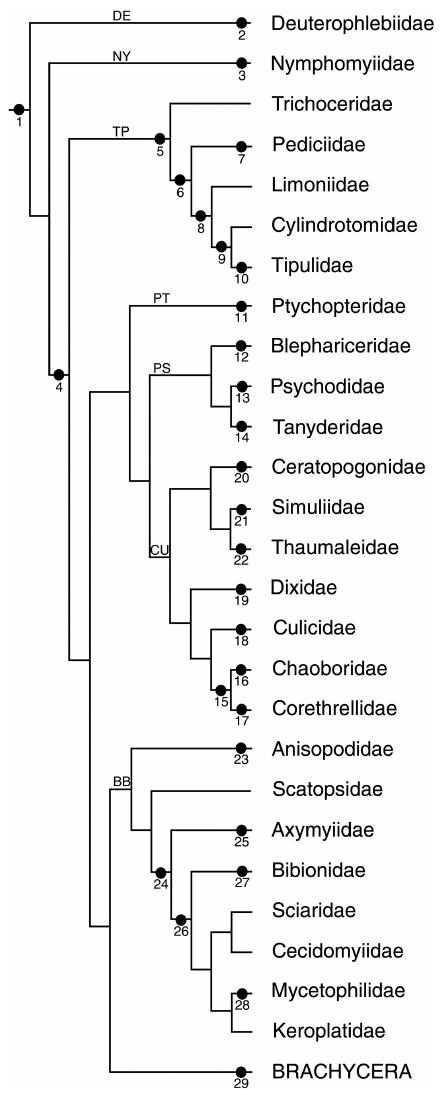
Figure 2 . Characters mapped on the cladogram of Wiegmann et al. [23, Figure 1]. potential apomorphies indicated by black points. 1, Diptera: Adult head: dense vestiture of microtrichia, presence of a clypeolabral muscle, reduction of the postmentum, transformation of the labial palps into labellae (equipped with simple furrows). Larval head: labrum equipped with a dense fi eld of hairs, presence of a hypostoma (hypostomal bridge) with triangular teeth. 2, Deuterophlebiidae: Adult head: antenna inserted laterally, widely separated, last antennal segment extremely elongated, labrum, maxilla, and labium reduced (inclusive associated muscles), reduction of M. tento- riobuccalis anterior and M. hypopharyngosalivarialis. Larval head: presence of externolateral plates with growth lines (homoplasious character), labral brush consists of macrosetae, reduction of M. labroepipharyngalis, bifurcate distal antennal segment, presence of apical multitoothed mandibular comb (homoplasious character), largely membranous cardo. 3, Nymphomyiidae: Adult head: completely sclerotized rostrum, club-shaped antenna with enlarged fi rst and elongated terminal segment, completely reduced tentorium, reduction of labrum, maxilla, and labium (inclusive associated muscles), loss of M. tentoriobuccalis (homoplasious character). Larval head: comple- tely reduced tentorium, labral brush consisting of macrosetae, reduction of M. labroepipharyngalis, bifurcate distal antennal segment, presence of an apical multitoothed mandibular comb. 4, Diptera, exclusive Deuterophlebiidae and Nymphomyiidae: Larval head: loss of M. tentoriostipitalis, presence of a pharyngeal fi lter. 5, Tipulomorpha: Adult head: sensilla on sensorial fi eld of third maxillary palpomere exposed on surface (homoplasious character). Larval head: deep ventromedian incisions of the head capsule. 6, Tipuloidea: Adult head: stipites partly fused. Larval head: presence of paired dorsolateral incisions, presence of growth lines on the extensive externolateral plates (homoplasious character). 7, Pediciidae: Larval head: mandible elongated and sickle-shaped, distinctly elongated maxillary palpo- mere. 8, Tipuloidea, exclusive Pediciidae: Larval head: head strongly retracted and fi xed in this position, presence of premaxillary